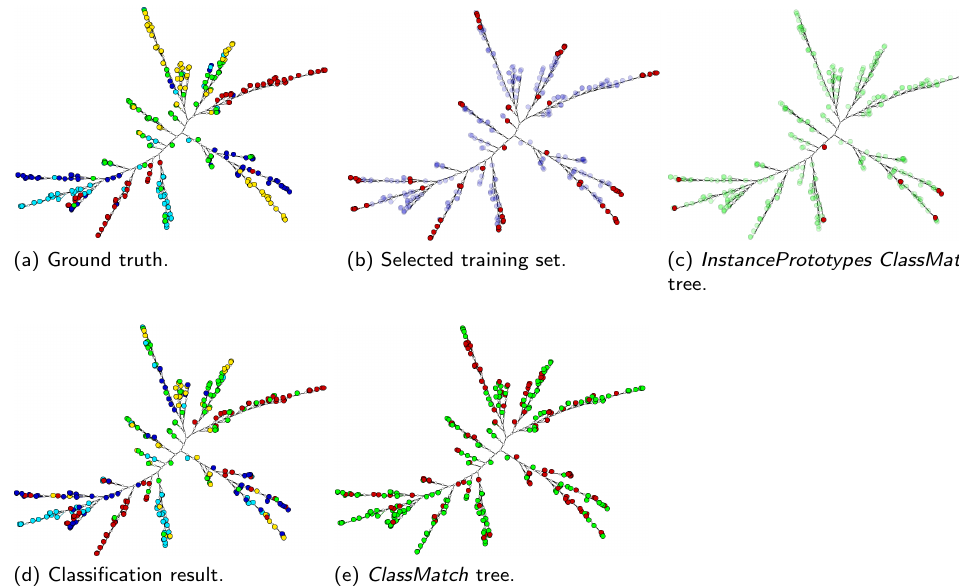
Figure 9. MILTree’s Bag Space Layout for the Corel-300 dataset. Visualization of the classification process from training set selection to classification result inspection. Visualization of ground truth of dataset ( a ), selected training ( b ), InstancePrototypes ClassMatch tree where bags with unsuitable instance prototypes are identified ( c ), visualization of classification result ( d ) and its correspondent ClassMatch tree ( e ). Note that the InstancePrototypes ClassMatch tree only shows the bags that were misclassified in the training set, whereas the ClassMatch tree shows the bags that were misclassified in the test data and training set. Hence, for evaluating the classification results, users should only inspect the ClassMatch tree ( e